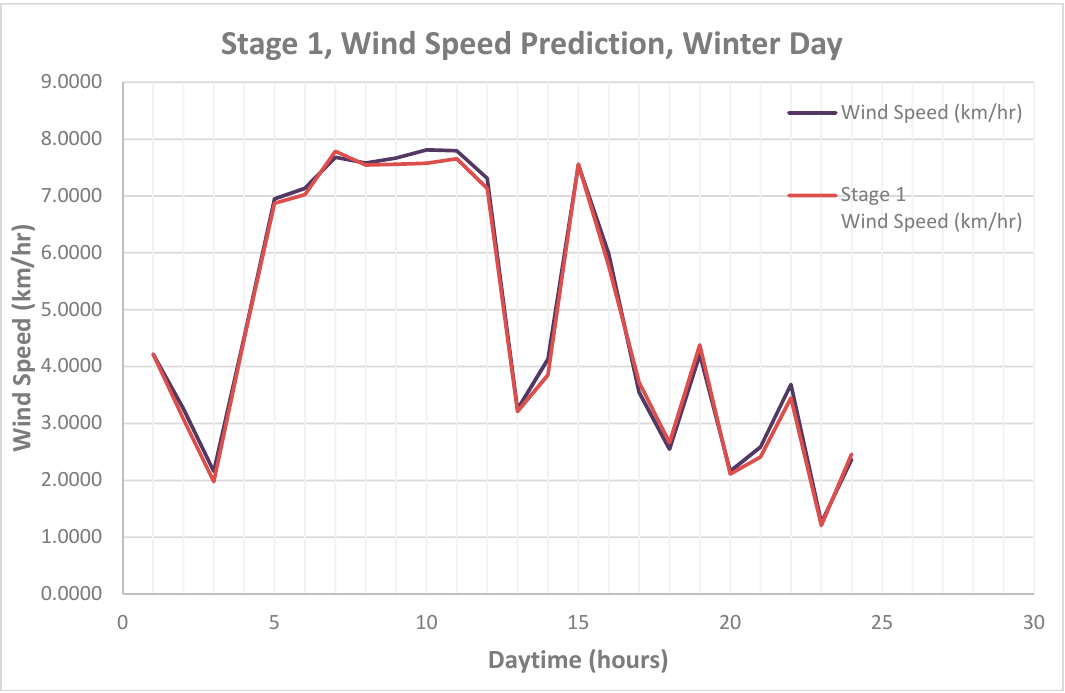
Figure 9. Wind Speed forecasting results from Stage 1, Winter Day.